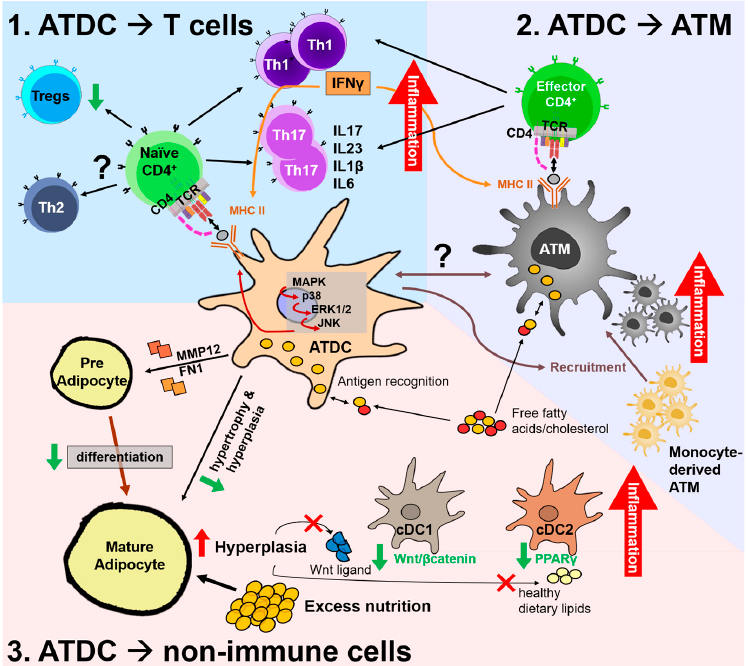
Figure 2. Potential regulatory mechanisms by adipose tissue dendritic cells (ATDCs) in the adipose tissue (AT) environment by interaction with T cells ( 1 ), AT macrophages (ATMs) ( 2 ), and non-immune cells ( 3 ). In obese AT, uptake of antigens or lipids such as free fatty acids and/or cholesterol by ATDCs induces activation of the mitogen-activated protein kinase (MAPK) pathway, leading to increased MHC-II expression and induced maturation. 1. Obese ATDCs lead the Th1 and Th17 subset proliferation that creates the pro-inflammatory environment. Released IFN γ is capable of inducing MHC-II expression in antigen-presenting cells, creating a loop to amplify Th1 and exacerbate AT inflammation. In obesity, ATDCs have a lower capability to induce Tregs proliferation, while interaction with the Th2 subset is unknown. Separately, ATMs can uptake antigens inside the AT and induce proliferation of local effector CD4 + T cells into Th1 and/or Th17 subsets. 2. ATDCs partly regulate monocyte-derived ATM recruitment into AT, yet their interaction remains